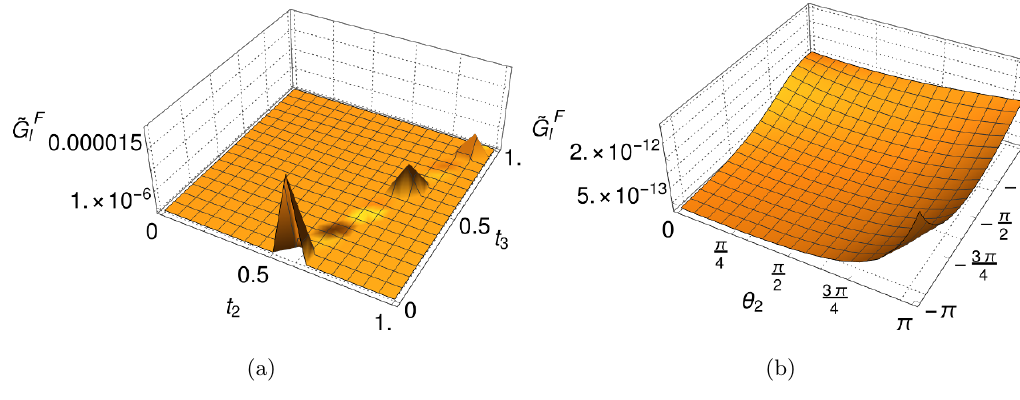
Figure 10 . A slice of the absolute value of the I246 1 integrand at O ( (cid:15) 0 ) in the (cid:12)rst over-threshold region (a) without a complex mapping, t 0 = 1, t 1 = 1 mapping, (cid:18) 0 = (cid:0) (cid:25) , (cid:18) 1 = (cid:0) (cid:25) TayInt , setting u = 3 : 2 m 2